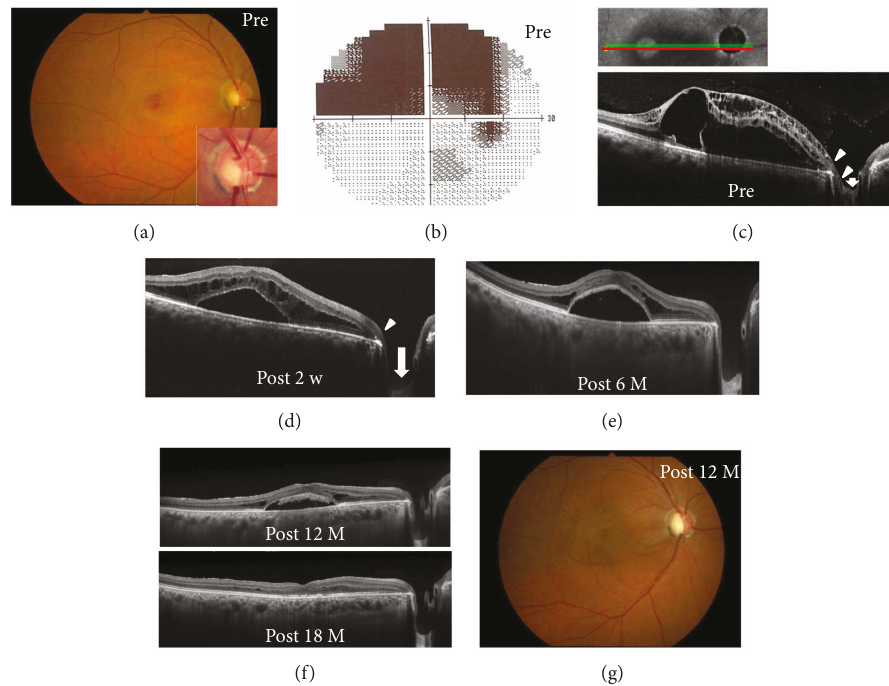
Figure 6: Photographs of the right eye in a 52-year-old patient with retinoschisis associated with glaucoma without posterior vitreous detachment (case 7). (a) Fundus photographs before surgery demonstrating retinal elevation, retinal folds extending from the macula to the optic disc, and glaucomatous optic disc cupping with nerve fi ber layer defect but no obvious optic disc pit. (b) Humphrey threshold 30-2 perimetry before surgery showing decreased sensitivity at the Bjerrum area. (c – f) Horizontal scan images of enhanced depth imaging optical coherence tomography. An image before surgery showed retinal schisis with foveal detachment extending from the optic disc to the macula, the epipapillary membrane (c, arrow), and a shallow tunnel-like hypore fl ectivity (c, arrowheads) directly connecting the retinal schisis and the 8 o ’ clock margin of the disc (c). The posterior hyaloid membrane was attached to the vicinty of the disc. Two weeks after pars plana vitrectomy, retinal schisis decreased with an obscure tunnel-like hypore fl ectivity (d, arrowhead). The extent of the disc cupping was obviously deeper than preoperative one following the removal of the membrane tissue (d, arrow). Retinal schisis with macular detachment gradually decreased (d – f) and was completely resolved 18 months after surgery (f). (g) Fundus photograph showed the decrease of macular elevation at the macula but no optic disc pit at 12 months after